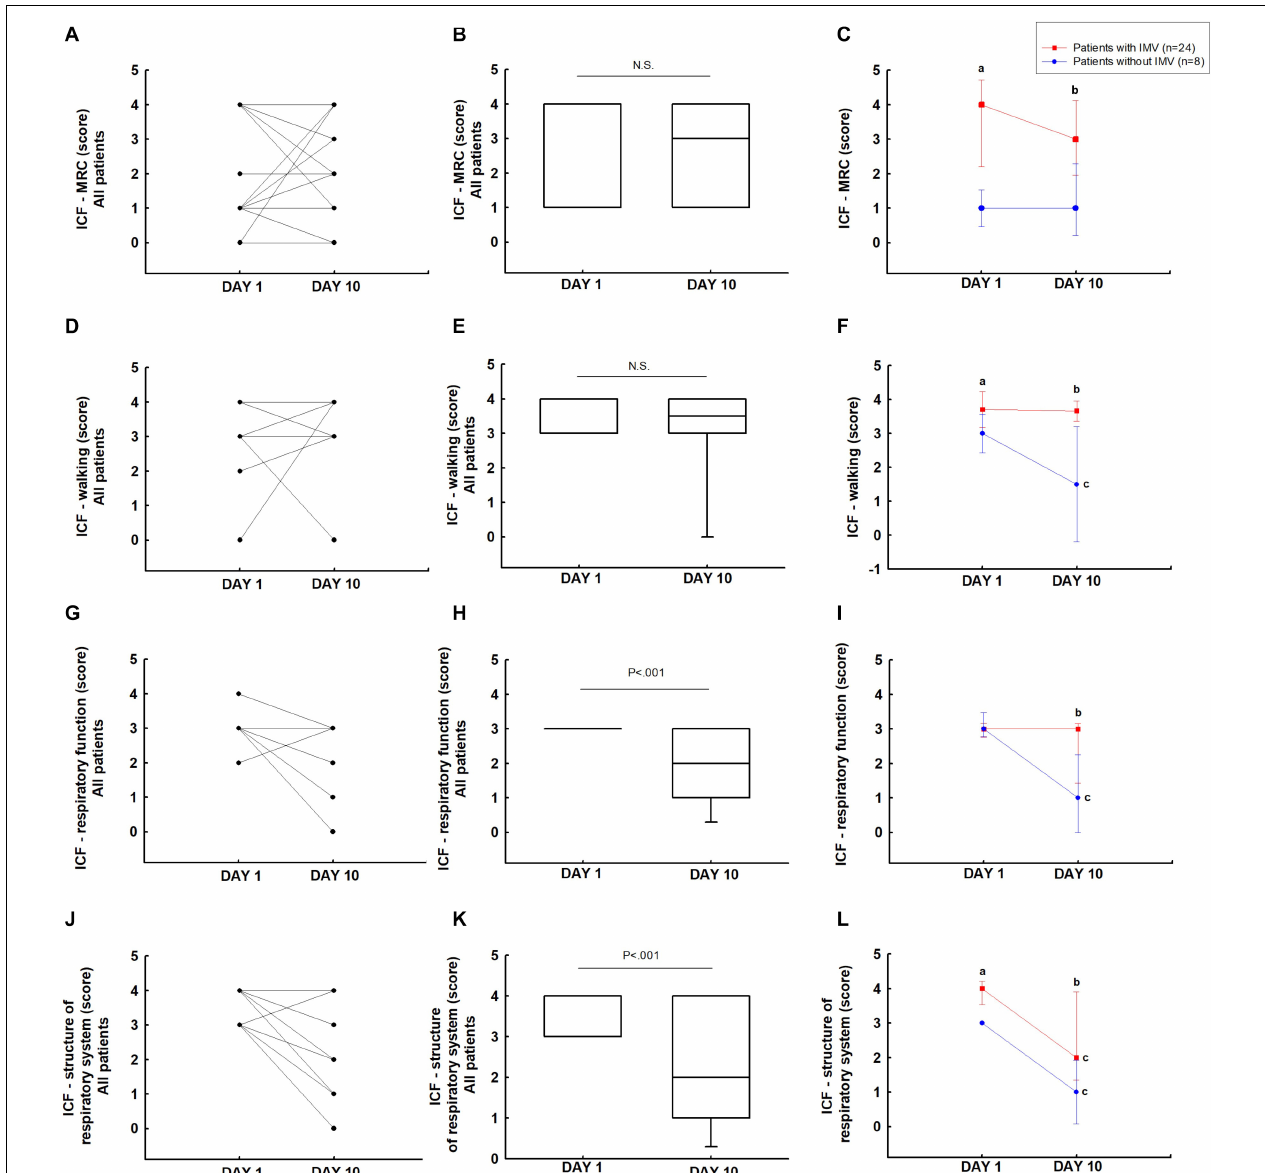
FIGURE 5 | Function assessed: ICF-MRC (A–C) , ICF-walking (D–F) , ICF-respiratory function (G–I) , and ICF-structure respiratory system (J–L) . a P < 0.05 vs patients without IMV on day 1; b P < 0.05 patients without IMV on day 10; c P < 0.05 vs day